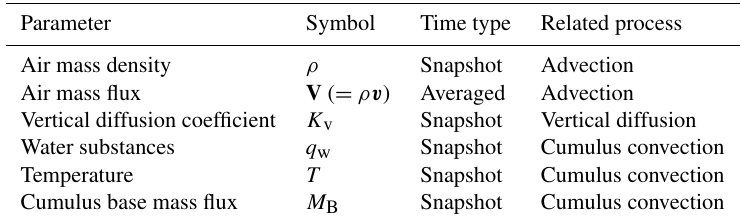
Figure 1. The grid distribution of NICAM glevel-5. Triangular elements produced by dividing an icosahedron five times (a) and control volumes constructed by connecting the mass centers of the triangular elements (b) . Table 1. Meteorological parameters used for the offline forward and adjoint